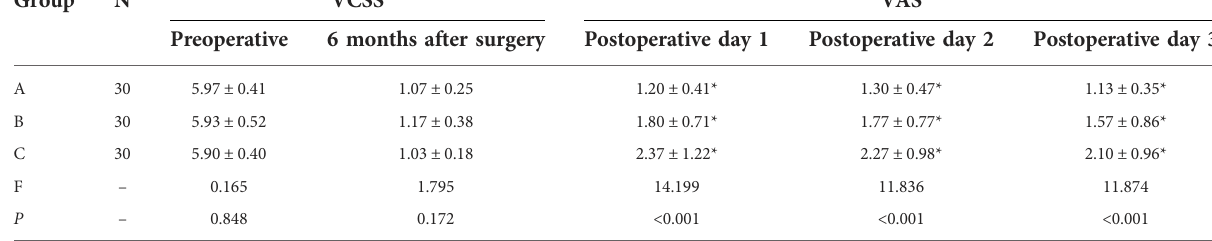
TABLE 5 Comparison of postoperative pain degree among three groups (x±s). Group